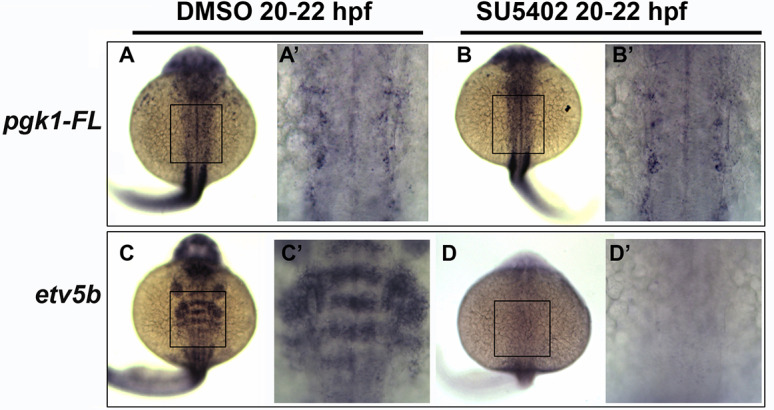
Fgf signaling is not required for normal pgk1-FL expression.(A–D’) Dorsal views (anterior to the top) of expression of pgk1-FL and etv5b in wild-type embryos incubated with 0.5% DMSO or 50 uM SU5402 from 20 to 22 hpf. Images show whole embryos next to enlargements (primed letters) of the indicated regions of the hindbrain. SU5402 had no effect on expression of pgk1-FL but completely eliminated expression of etv5b.